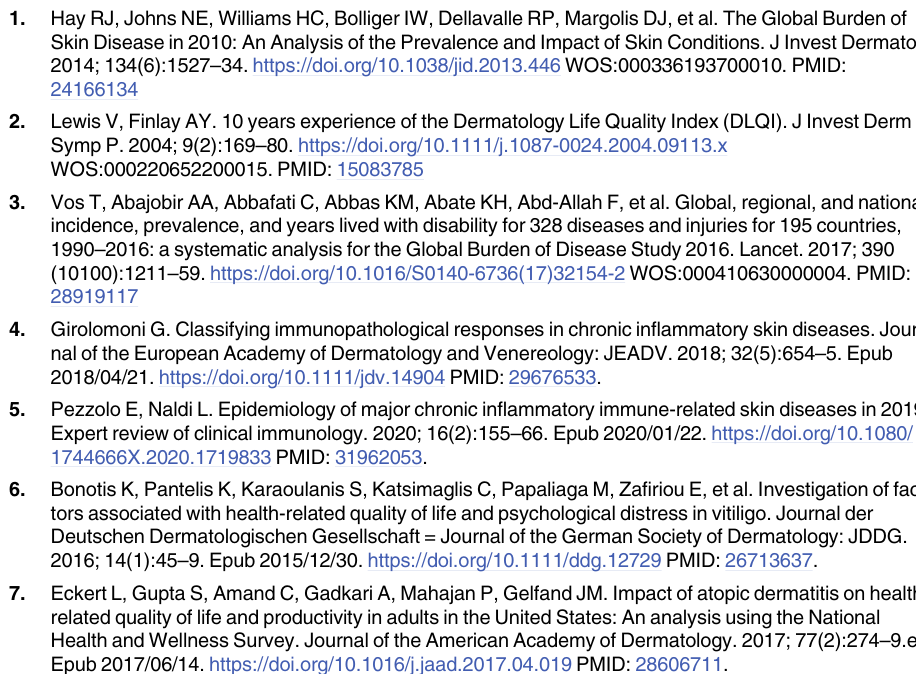
S1 Table. Systematic search strategy. S2 Table. Serum vitamin E levels of different skin diseases. S3 Table. Quality of case control studies. S4 Table. Subgroup analysis of the association between serum vitamin E levels and skin